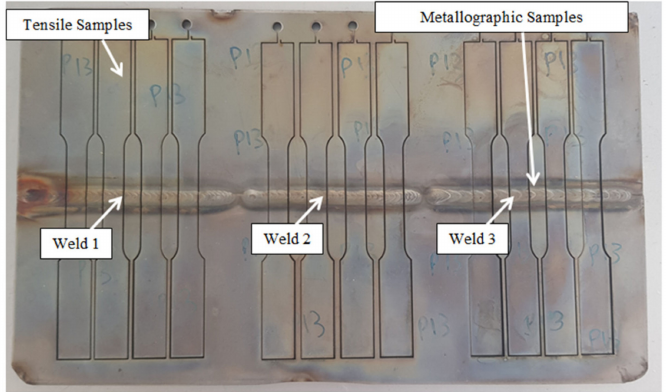
Figure 3. Locations of the tensile and metallographic samples extracted from the welded sheets. The extracted metallographic samples were mounted in conductive Bakelite in batches of five for the homogenous welds and in batches of three for heterogeneous welds. On mounting the samples, the molds were grinded using silicon carbide papers of different grits, including 120, 240, 600, 900, 1200 and 2500, followed by polishing using 9 µ m, 3 µ m and 0.04 µ m gels. The samples were later etched using acetic glycergia solution, which revealed the microstructure within the fusion zone (FZ) as well as the heat-affected zone (HAZ). Acetic glycergia is a solution of 5 mL glycerol, 15 mL hydrochloric acid, 10 mL nitric acid and 10 mL acetic acid. The samples were etched in this solution for approximately 5 s. All the geometrical features including the crown height ( CH ), crown width ( CW ), penetration ( PEN ), back width ( BW ), crown angle ( CA ), back angle ( BA ), crown radius ( CR ), back radius ( BR ) and cross-sectional area ( WA ) were measured using a Leica DM2700 microscope, as shown in Figure 4.